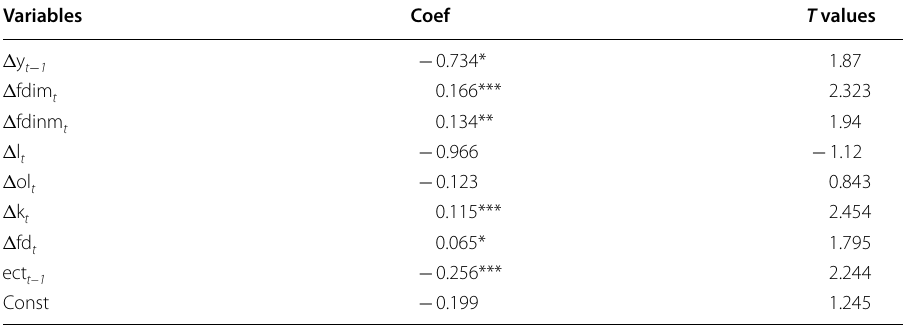
Table 3 Unrestricted error correction model (ECM): short-run coefficients (dep variable: y ) Variables